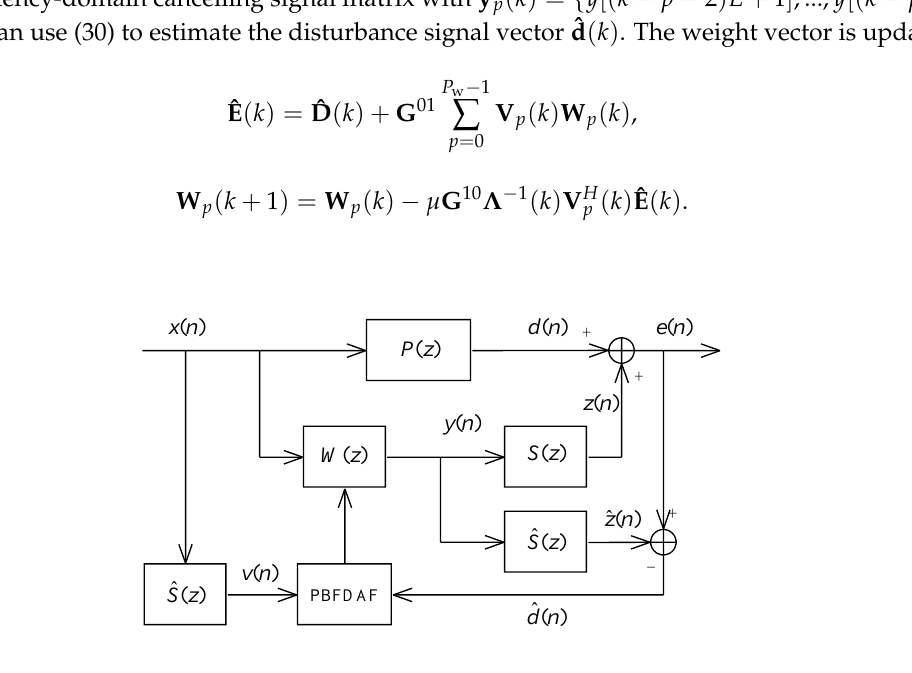
Figure 5. Proposed delayless algorithm.